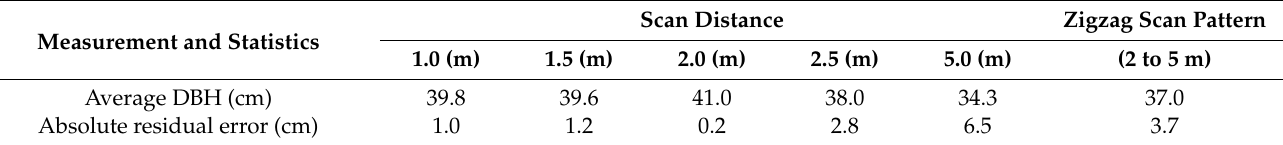
Table 4. Evaluating iPad LiDAR performance from various distances.